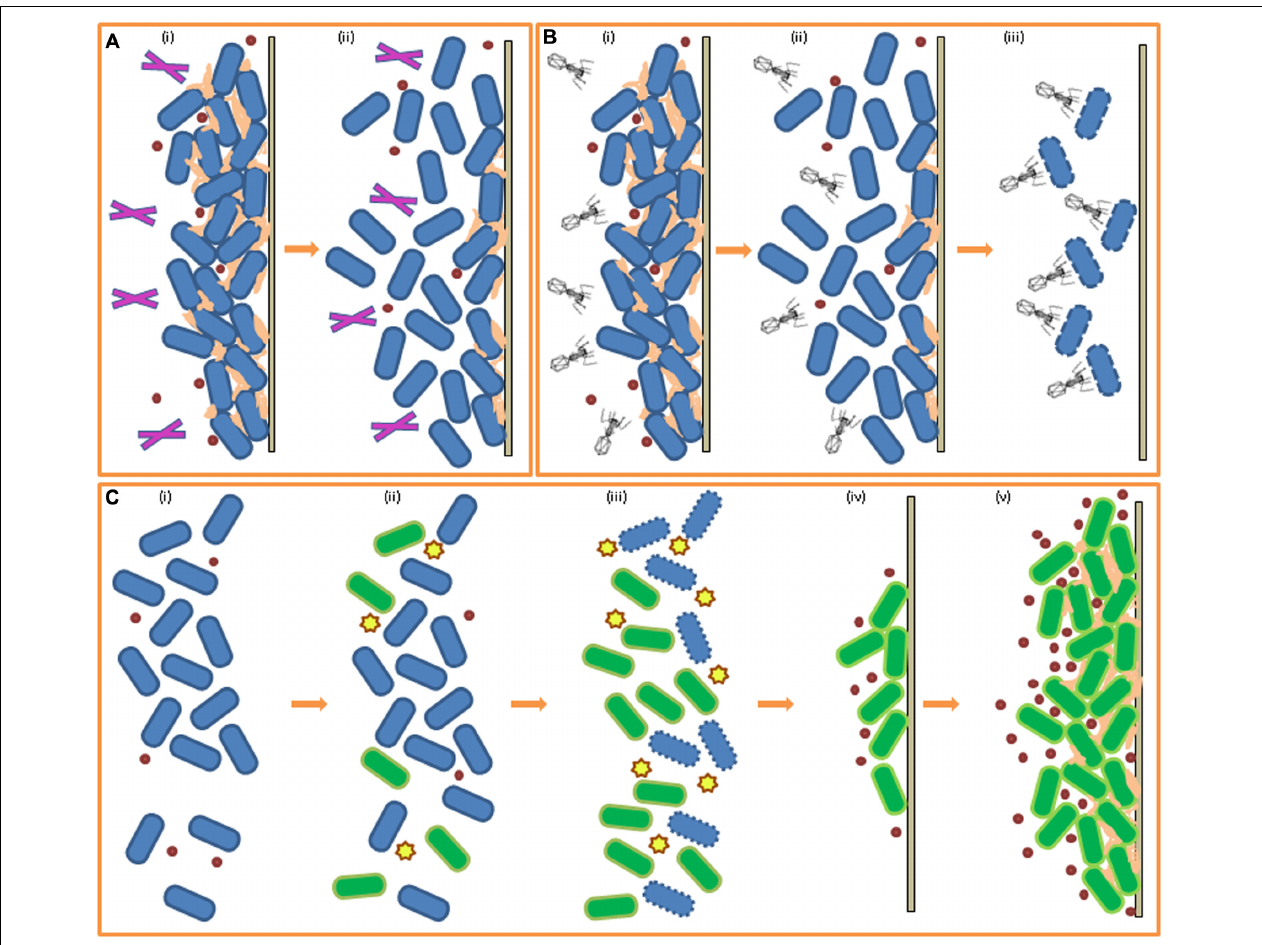
FIGURE 2 | Biofilm control through enzymes, phage, and bacteriocins. (A) Effect of enzymes on pre-existing biofilm (i) biofilm formed, EPS production, addition of enzymes (ii) breakdown of EPS and biofilm reduction by enzymatic action. (B) Effect of bacteriophage on pre-existing biofilm (i) biofilm formed, EPS production, addition of phage (ii) degradation of EPS by phage, reduction of biofilm (iii) bacterial cells in biofilm targeted by targeted for infection by phage. (C) Effect of bacteriocins and competitive exclusion on biofilm-forming cells (i) planktonic cells of species A (blue) (ii) addition of bacteriocin-producing species B (green) (iii) targeting of species A by bacteriocins, increase in number of species B cells (iv) increase in QS molecule concentration for species B, attachment to solid surface (v) biofilm formation of species B in place of species